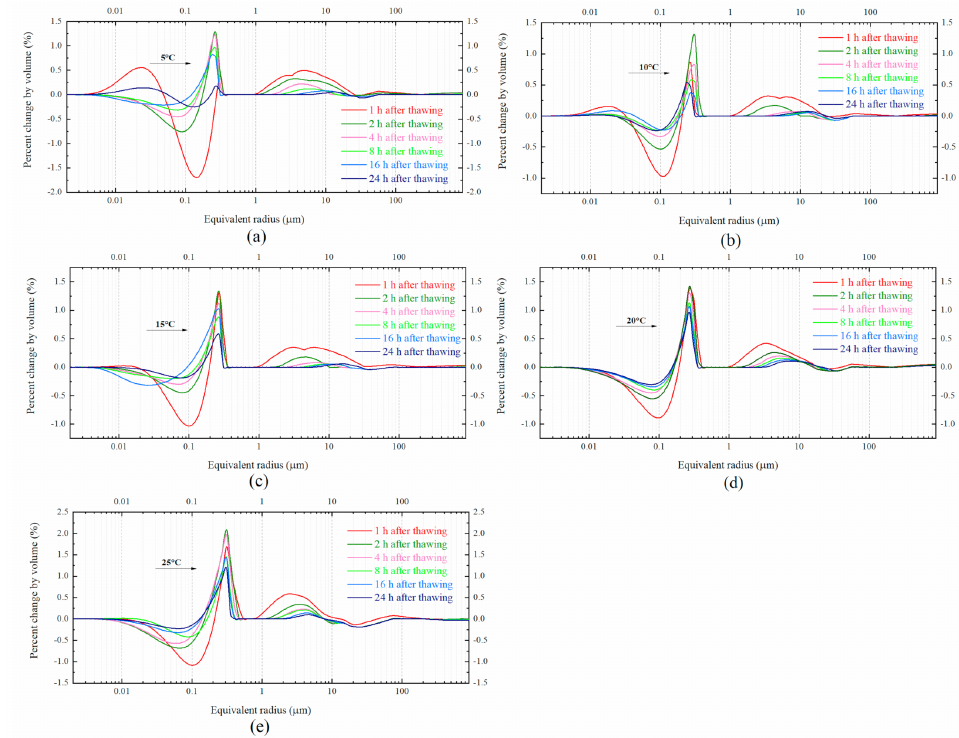
Figure 17. PSD change at different thawing temperatures: ( a – e ) show the percent change at 5, 10, 15, 20, and 25 ◦ C,